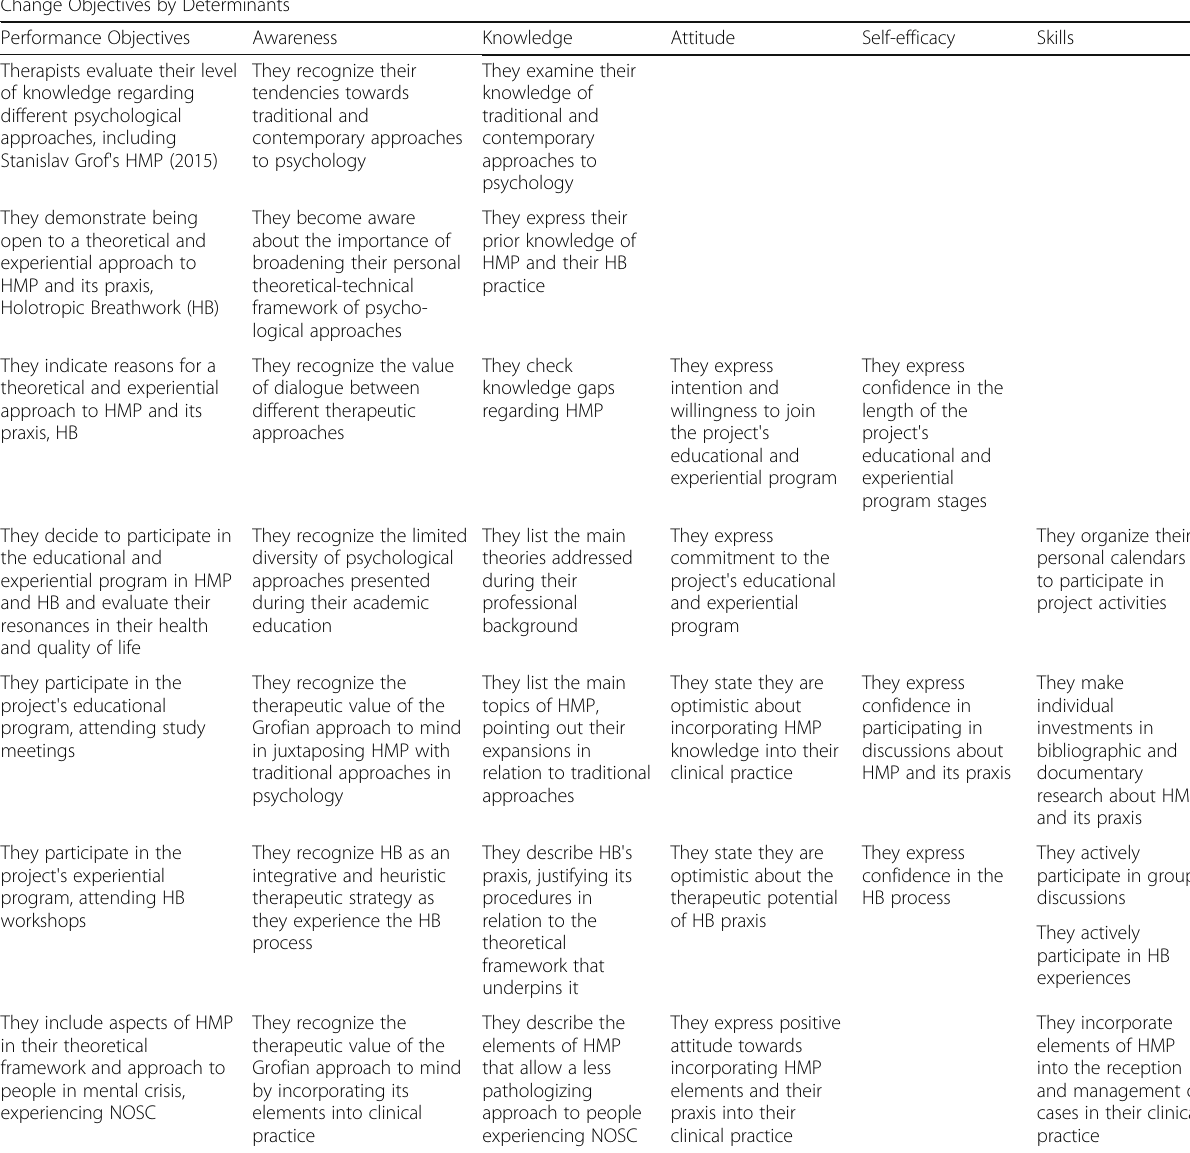
Table 2 Matrix of interactions between performance objectives, change objectives, and behavioral determinants Change Objectives by Determinants Performance